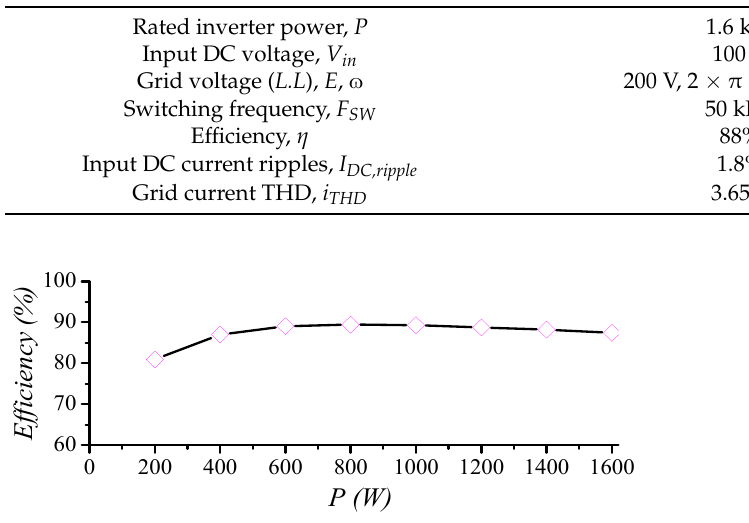
Figure 11. Efficiency profile of the IFBI under load variation.